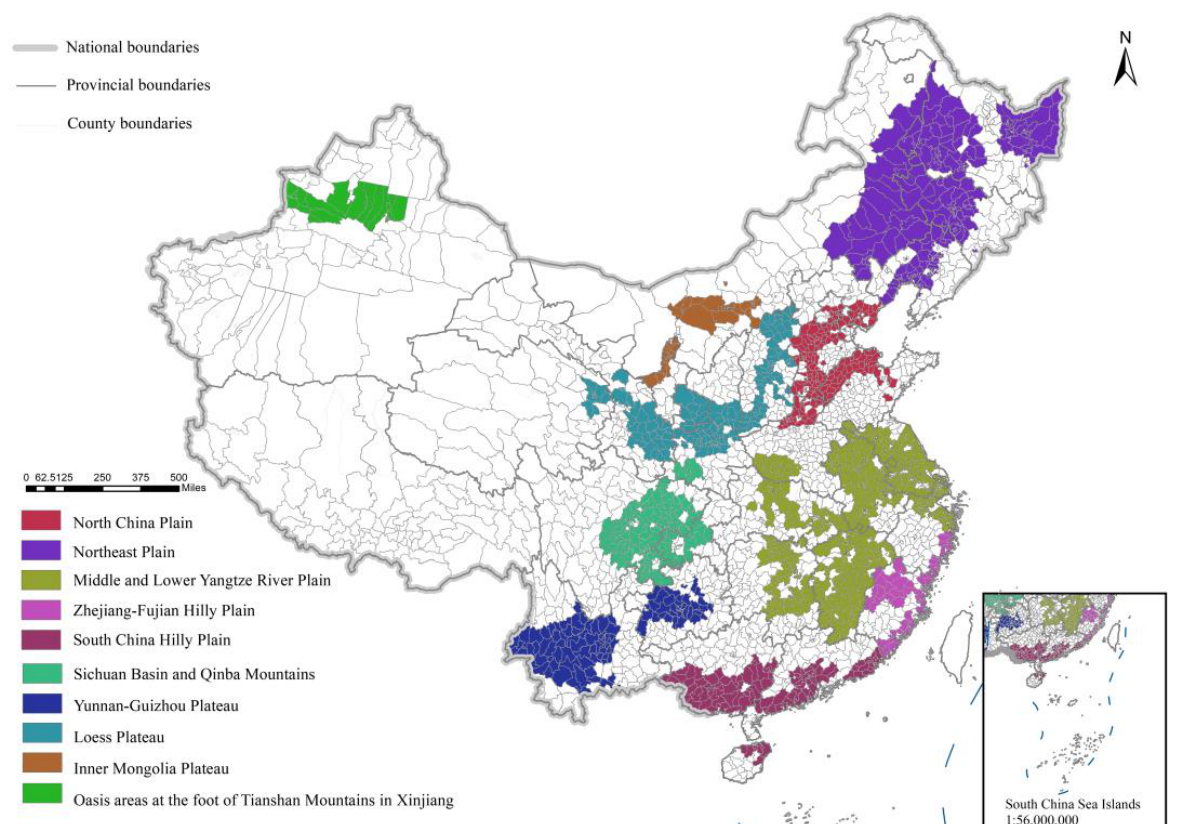
Figure 3. Key areas for land consolidation identified in the National Plan for Land Development and Consolidation (2001–2010), including the North China Plain, Northeast Plain, Middle and Lower Yangtze River Plain, Zhejiang–Fujian Hilly Plain, South China Hilly Plain, Sichuan Basin and Qinba Mountains, Yunnan–Guizhou Plateau, Loess Plateau, Inner Mongolia Plateau and Oasis areas at the foot of Tianshan Mountains in Xinjiang.